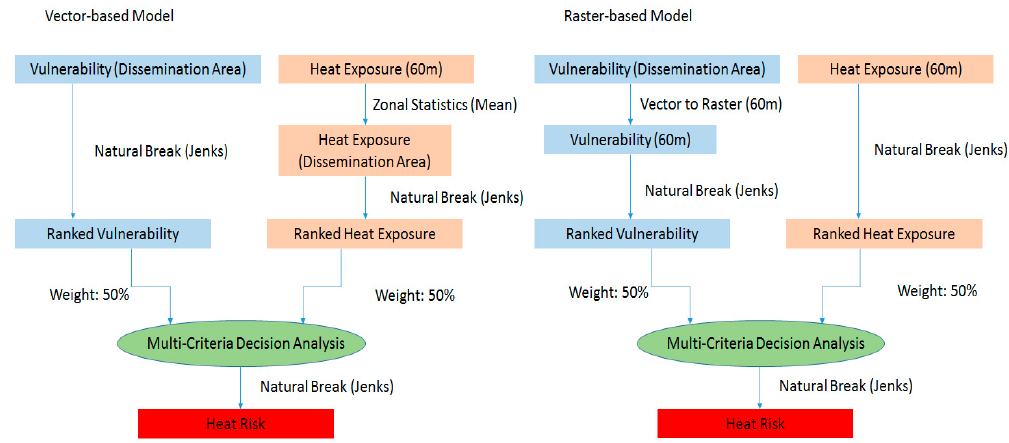
Figure 3. Flow Diagram from vector-based analysis ( Left ) and vector-based prediction ( Right ).